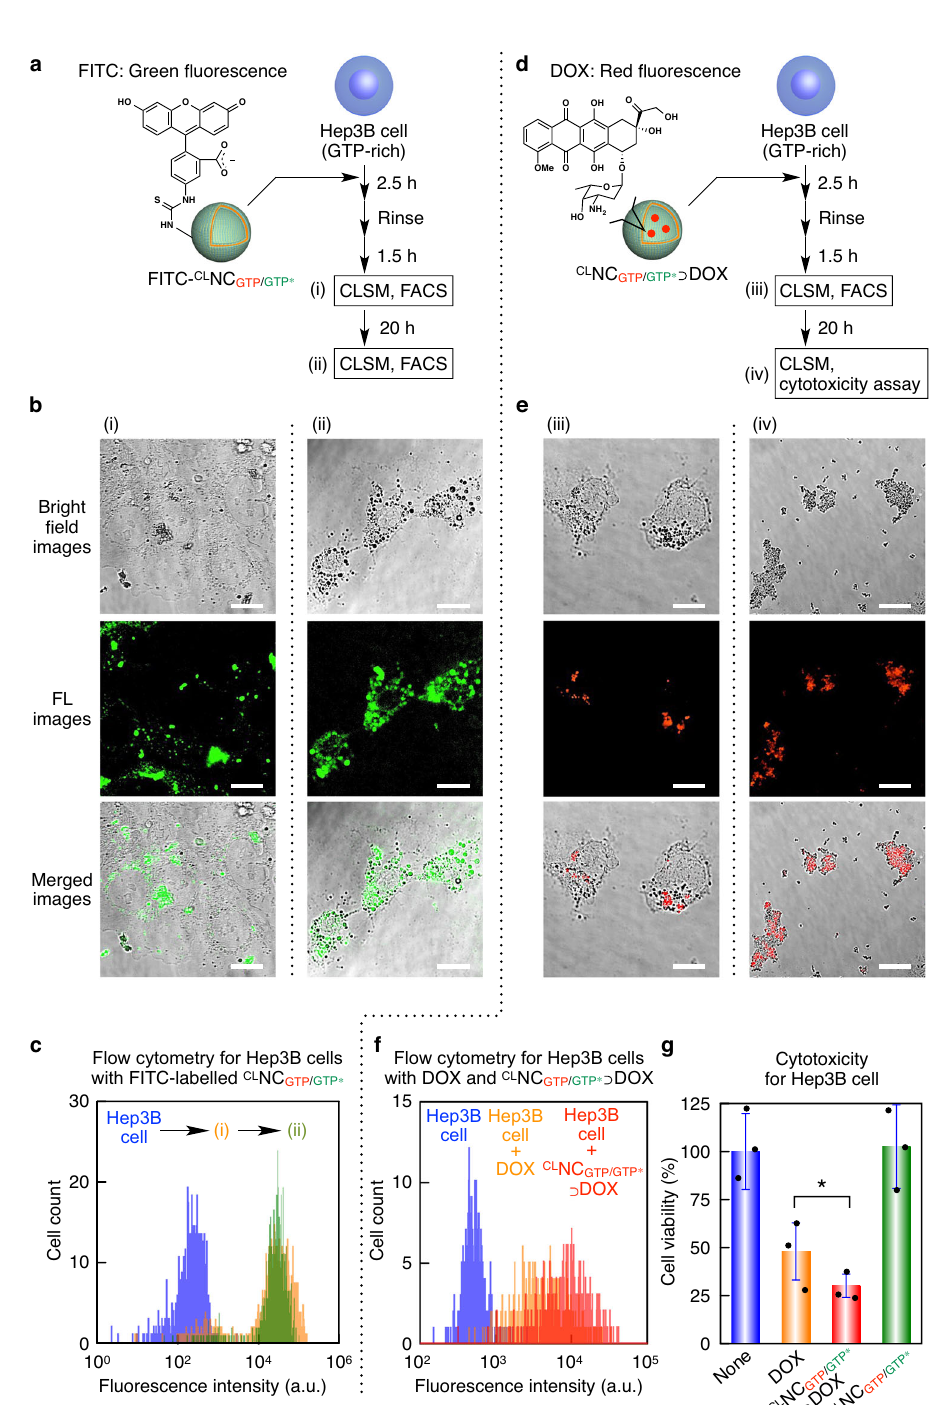
F luores c en c e intensit y (a. u .)